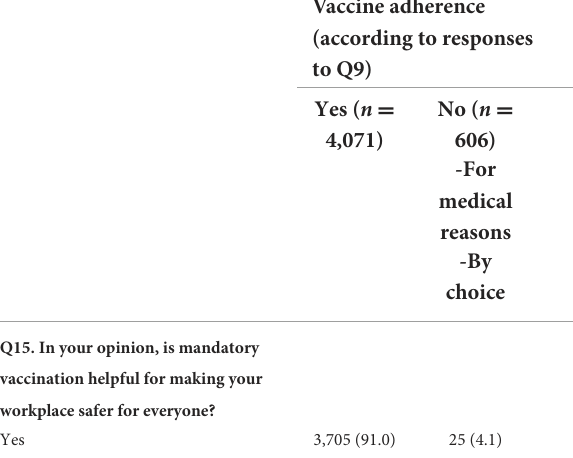
TABLE 3 Responses of vaccinated vs. unvaccinated healthcare professionals on mandatory vaccination (Q9) and occupational safety (Q15), individual freedom (Q17), and public health